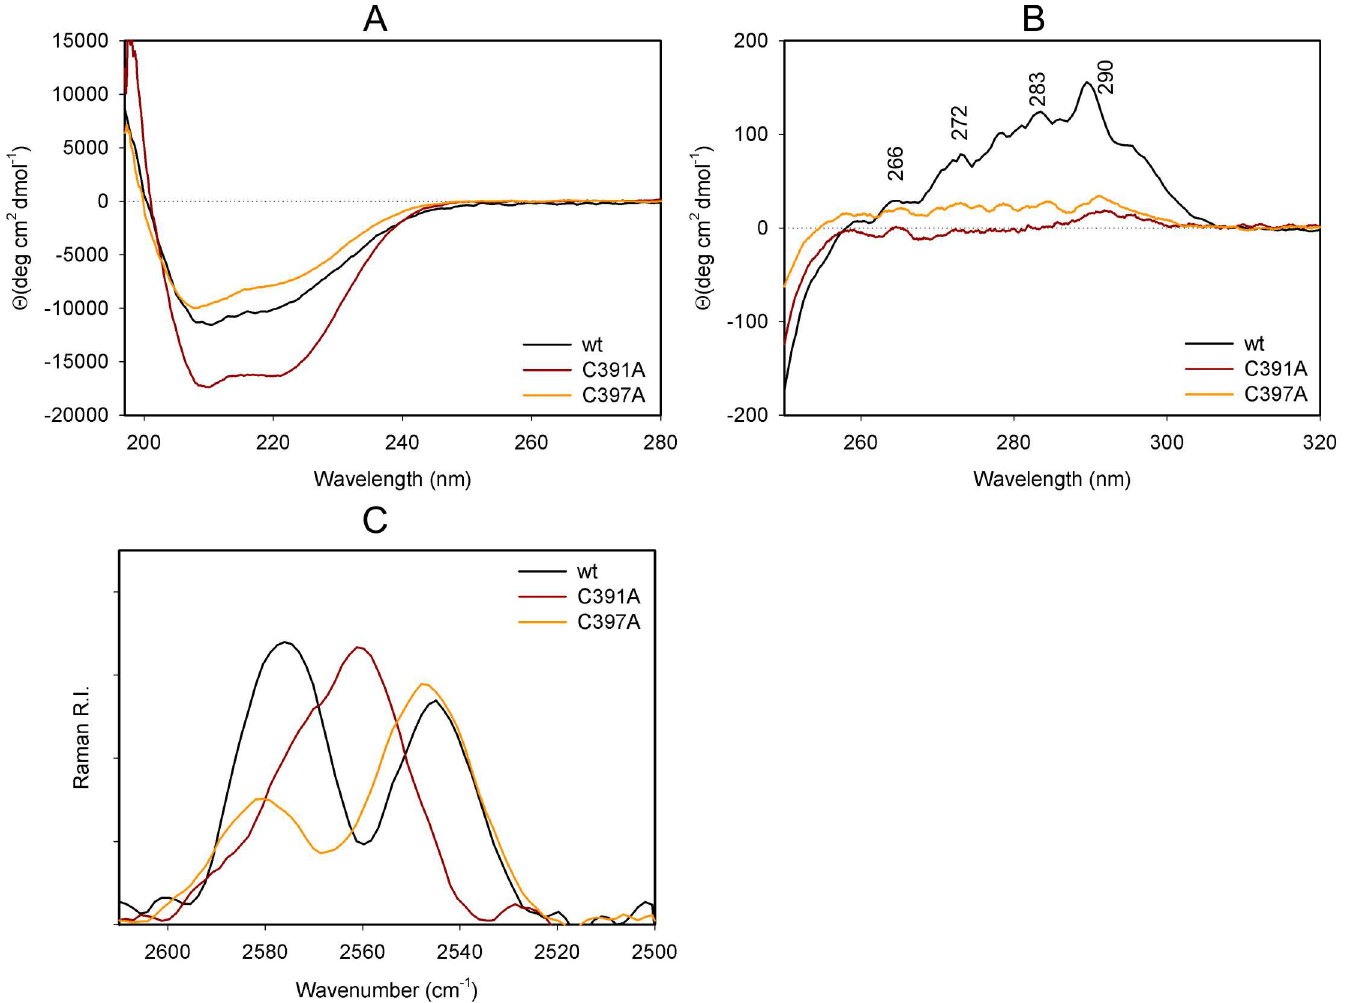
Fig 3. Analysis of secondary and tertiary structure changes in Pck Cys mutants. Far UV CD (A) and near UV CD (B) spectra of wt Pck and cysteine mutants (wt Pck–black, Cys391mutants–dark red, and Cys397mutants–orange. Raman spectra of wt Pck and Pck mutants in the cysteine S–H stretching vibrationsregion(2520 to 2600 cm -1 ) (C). wt Pck–black, Cys391 mutants–dark red, and Cys397